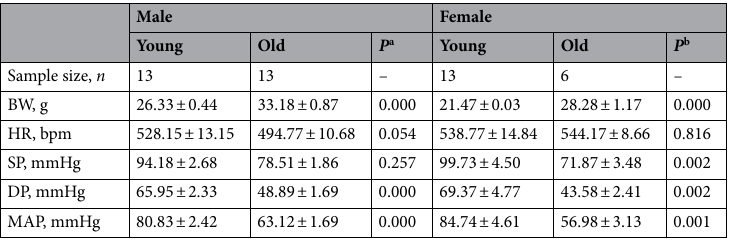
Table 1. Basic parameters of the study population. a Between young and old males; b between young and old females. BW body weight; HR heart rate; SP systolic pressure; DP diastolic pressure; MAP mean arterial